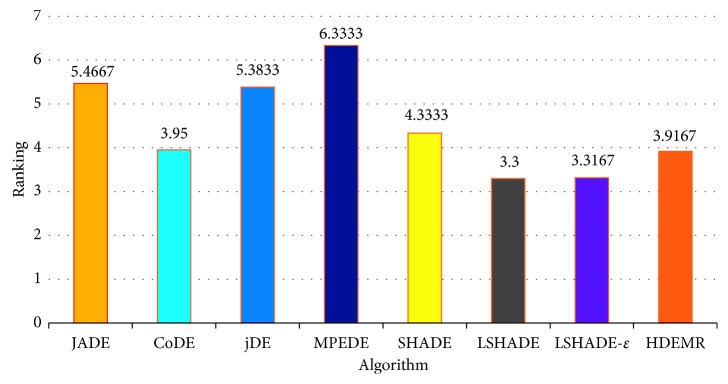
Average rankings of the eight algorithms by Friedman test for CEC2014 at D=10.